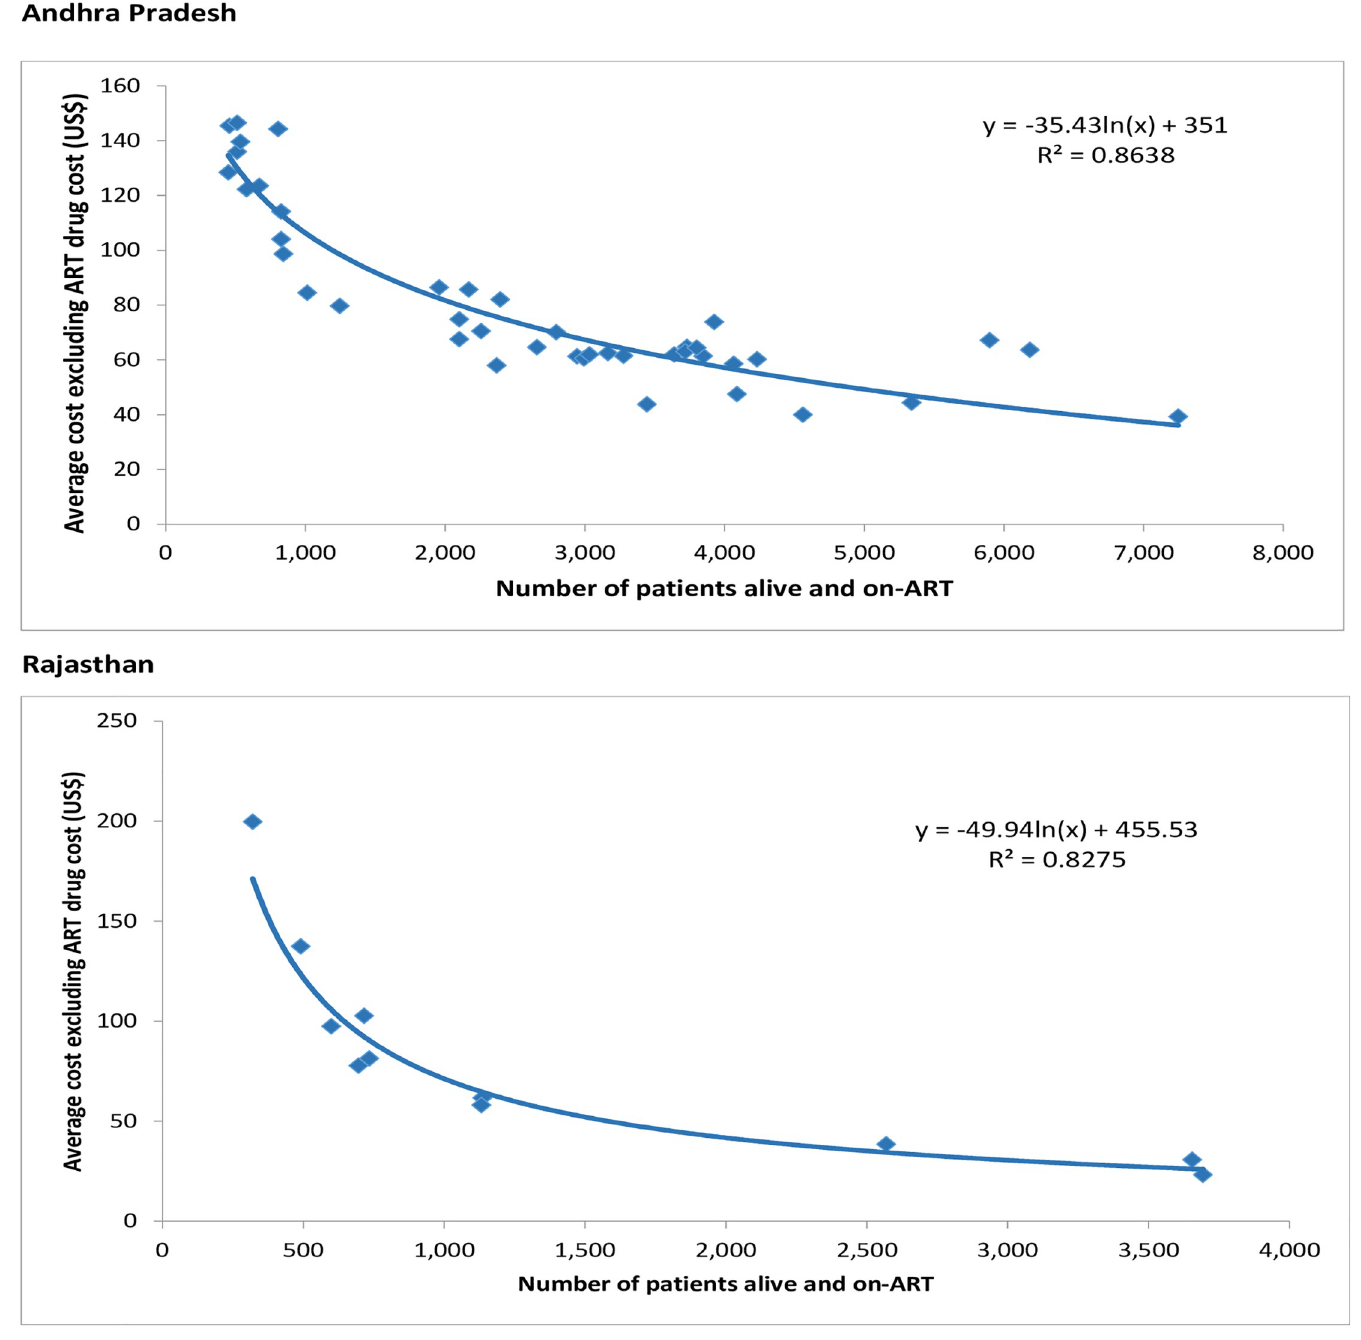
Fig 1. Relation between scale and other than ART drug cost per patient on ART for ART centres in undivided Andhra Pradesh and Rajasthan states in